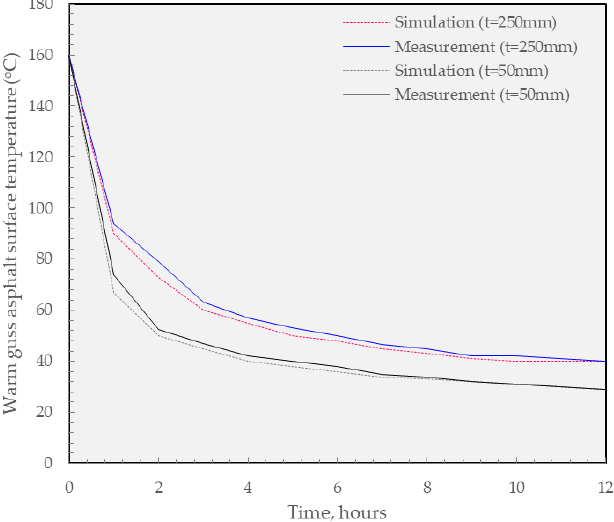
Figure 12. Comparison between the simulation and field measurement.